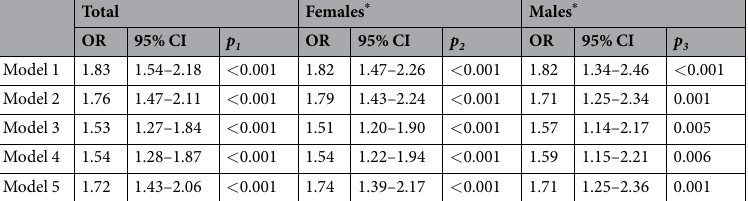
Table 5. Association between neck circumference (categorical data) and the risk of hypertension. * for females, neck circumference < 32.75 cm was the reference; for males, neck circumference < 35.75 cm was the reference. OR, odds ratio; CI, confidence interval. Model 1, unadjusted; Model 2, adjusted for age, fasting blood glucose, smoking and drinking status, salt consumption, physical activity and family history of hypertension; Model 3, adjusted for model 2 + body mass index categories; Model 4, adjusted for model 2 + waist circumference categories; Model 5, adjusted for model 2 + waist-to-hip